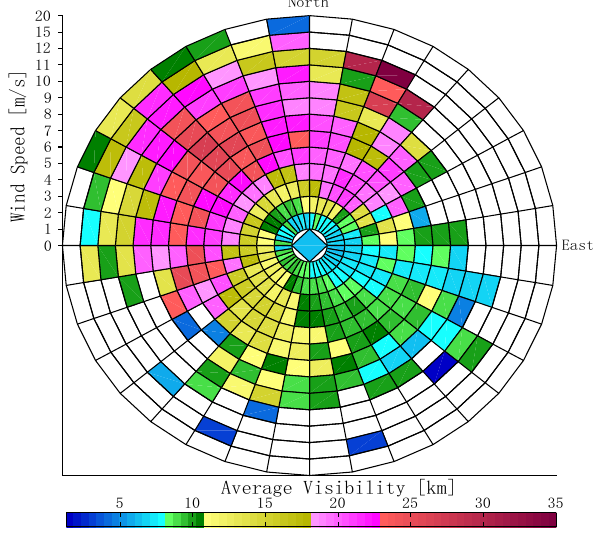
Fig. 7. Visibility distribution in relation to wind direction and wind speed in BCIA from 1999 to 2007.